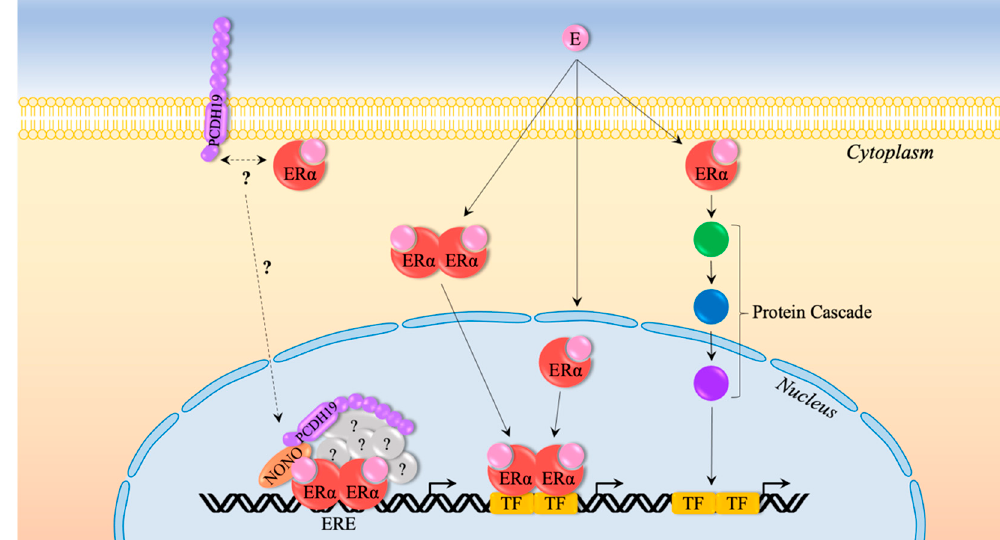
Figure 4. ER α -mediated gene regulation. ER α regulates gene expression through the genomic and nongenomic pathways. Genomic gene regulation involves the binding of oestrogen (E) to cytoplasmic or nuclear localized ER α , resulting in dimerization, a change in receptor confirmation, and, in the case of cytoplasmic ER α , translocation to the nucleus. ER α may recruit corepressors or coactivators (such as PCDH19 and NONO) to regulate gene expression either by directly binding an oestrogen-response element (ERE) or via binding to another transcription factor (TF). The nongenomic pathway involves membrane-bound ER α , rapidly and indirectly influencing gene expression through the cascade activation of DNA binding proteins [35].